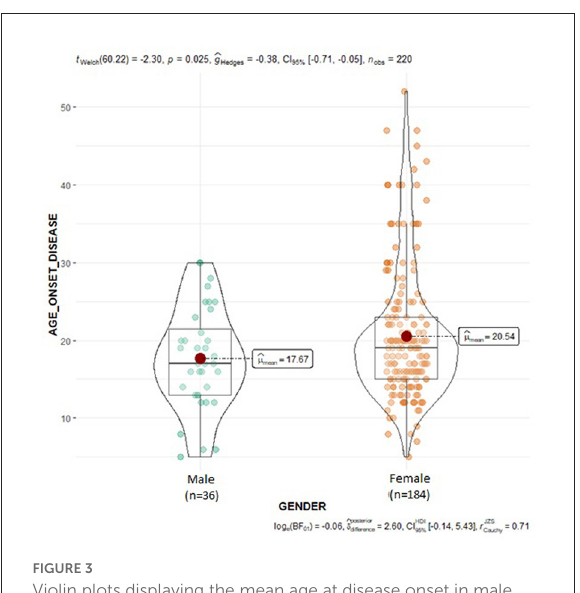
FIGURE3 Violin plots displaying the mean age at disease onset in male and female migraine